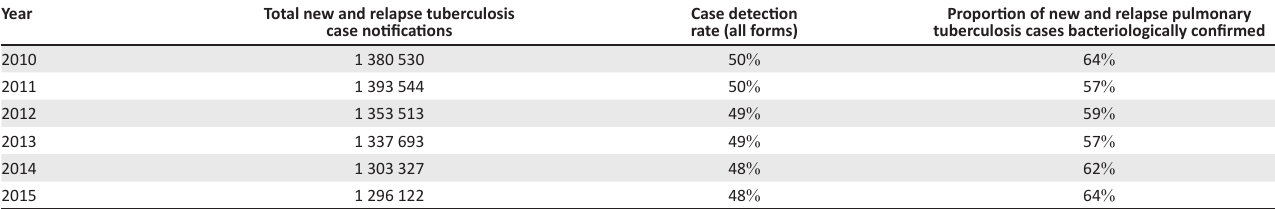
TABLE 2: New tuberculosis and relapse cases notified in Africa, 2010–2015. †